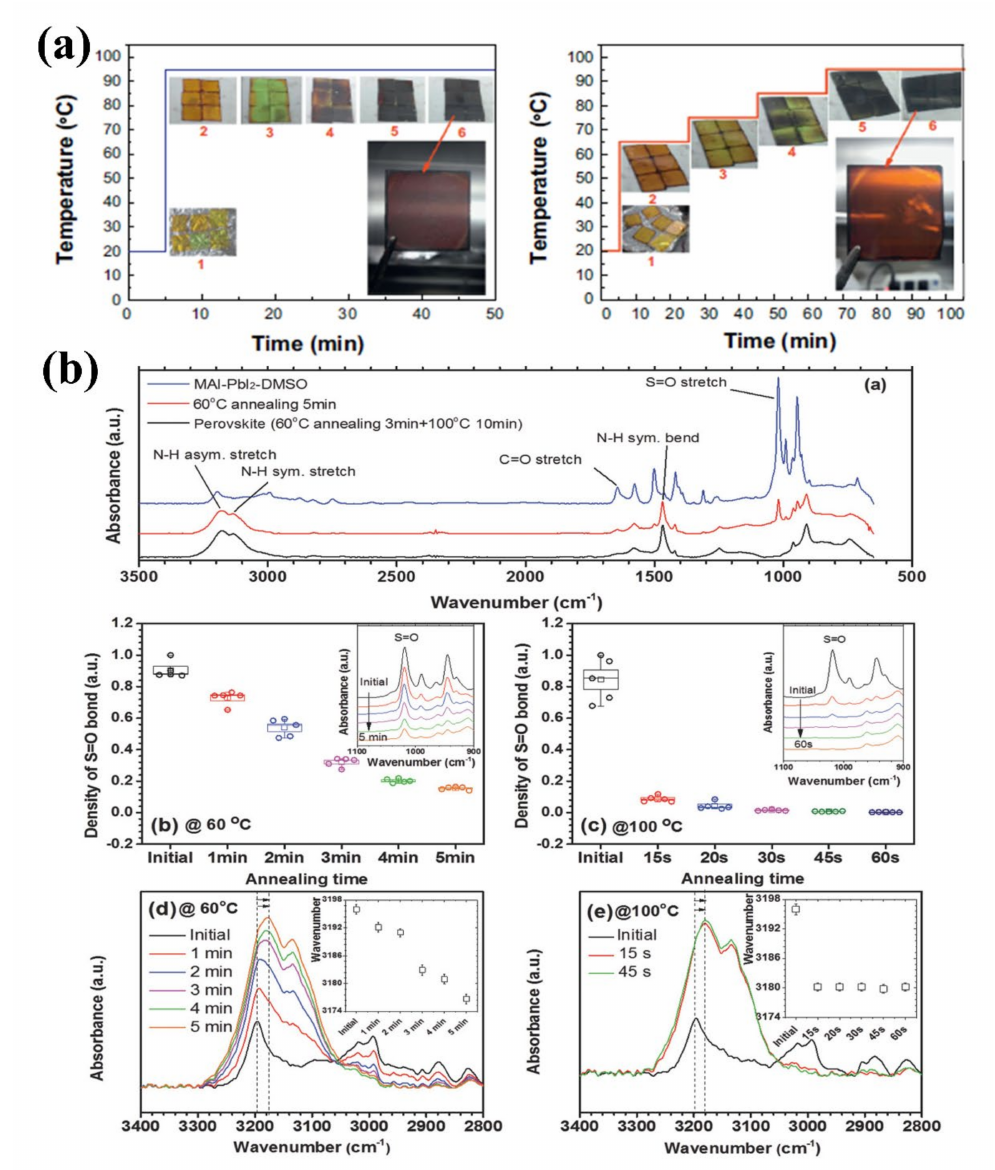
Figure 6. ( a ) The two different annealing methods adopted for the treatment of MAPbI 3 − x Cl x perovskite films: one-step and multi-step methods. (Reprinted with permission from Ref.